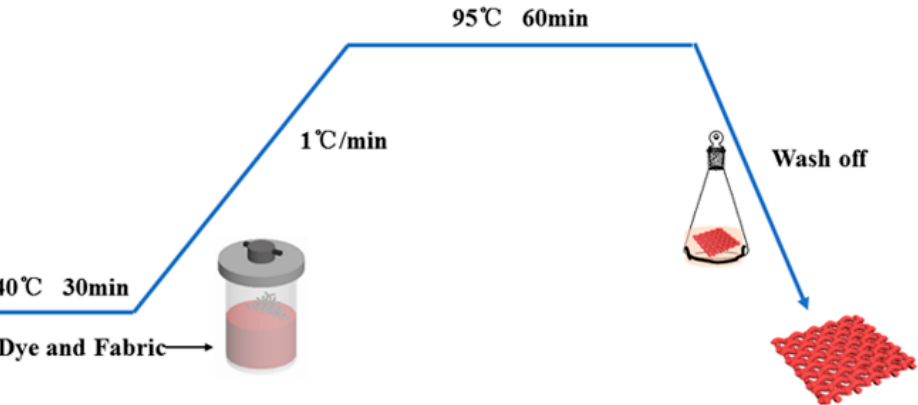
Figure 3. Dyeing profile of wool / acrylic blended fabric using heterocyclic dyes.